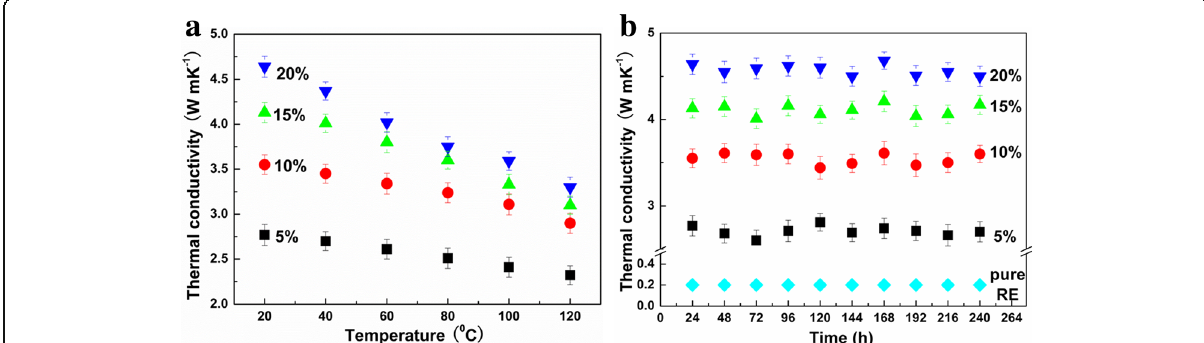
Fig. 5 Calculated thermal boundary resistance of the various samples. In order to simulate the practical work condition of electronic devices, the performances of the resulting TIMs under high temperature are detected ( a ). With increased temperature, the thermal conductivities of all TIMs decrease due to the enhanced Umklapp scattering. Although the Kapitza boundary scattering decreases at the same time (the probability of a phonon across the interface is proportional to e e − E KT ), the decrease cannot remedy the corresponding increase of the Umklapp scattering, leading to the whole decrease of thermal conductivity. Compared with that of the 3DGN-assisted sample, the stability of thermal conductivity of the RGO nanosheets added composites under high temperature is better because of the more sensitive Kapitza boundary scattering (as a results of the more boundaries of the RGO nanosheets). Moreover, no obvious degradation can be found for the thermal performance of the RGO-3DGNs-ER sample after 240 h continuous working ( b ), indicating the potential promising prospect of this TIM. The stability of the pure ER during a long work time is also recorded in b . The similar stabilities of the pure ER and the resulting composites (all the degradations of their thermal conductivities are less than 10%) indicate that no significant influence on the thermal stability can be found after adding the